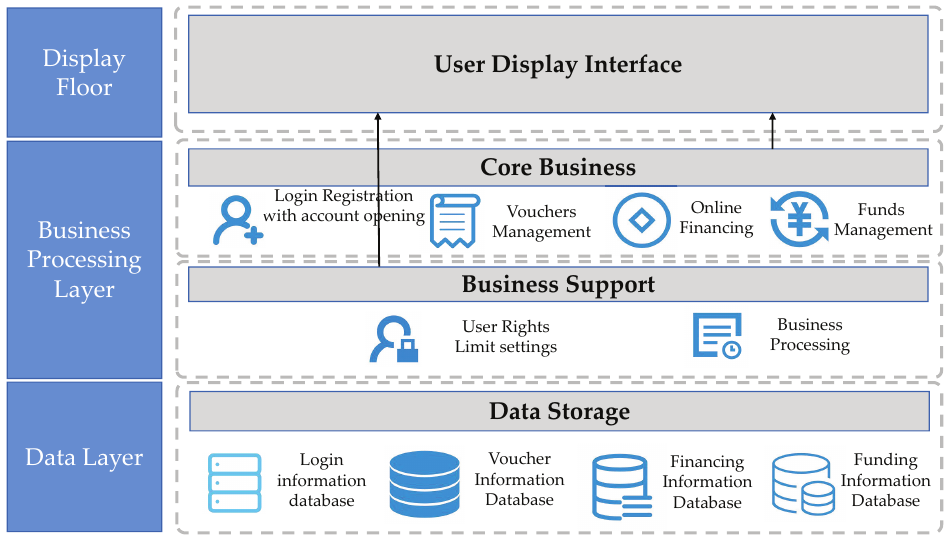
Figure 2. System overall architecture